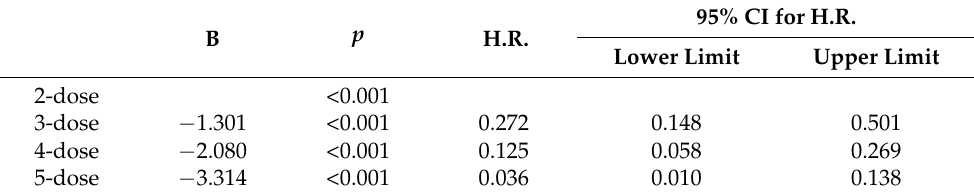
Figure 1. Hazard function by vaccine cohort and number of doses. Table 3. Protectivity from COVID-19 infection by the number of vaccine doses.